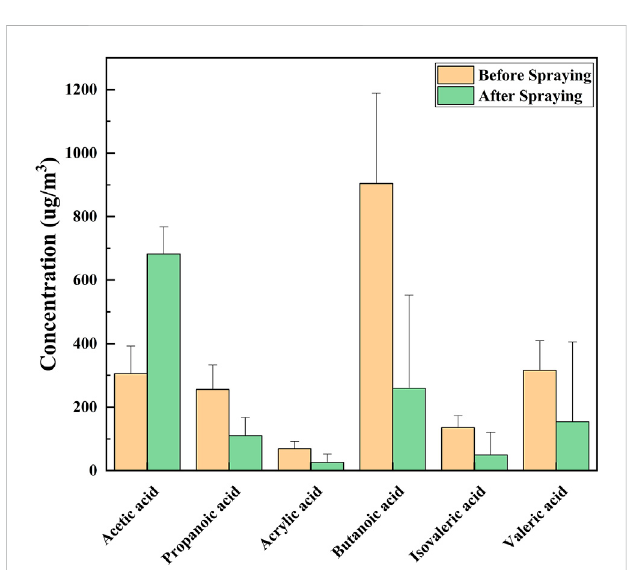
FIGURE 6 Changes in aromatic compounds before and after